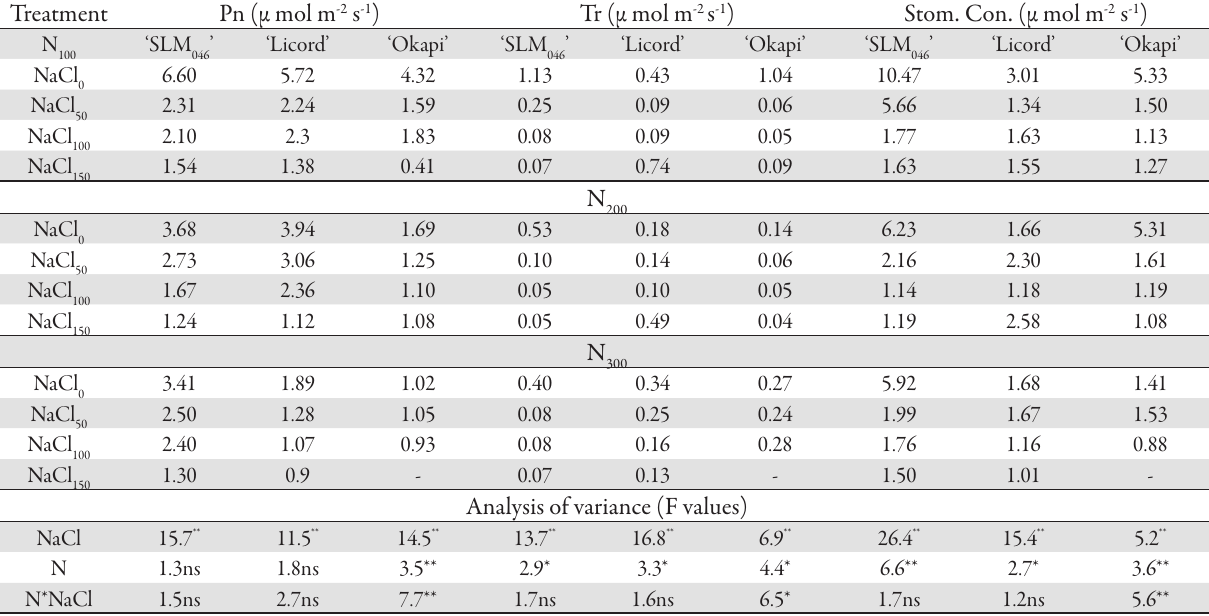
Tab. 2. The effect of salinity and N levels on the both Pn and transpiration rate of canola cultivars